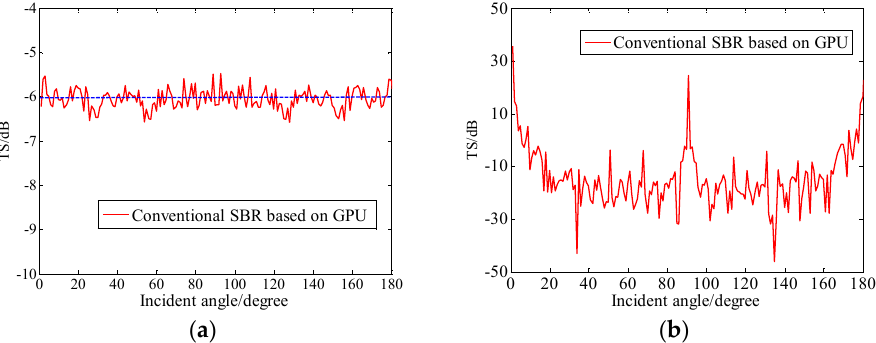
Figure 7. The TS value of the target at 15 KHz by conventional SBR algorithm based on GPU. ( a ) A rigid sphere with radius 1 m. ( b ) A rigid cylinder with length 6 m and radius 1 m.